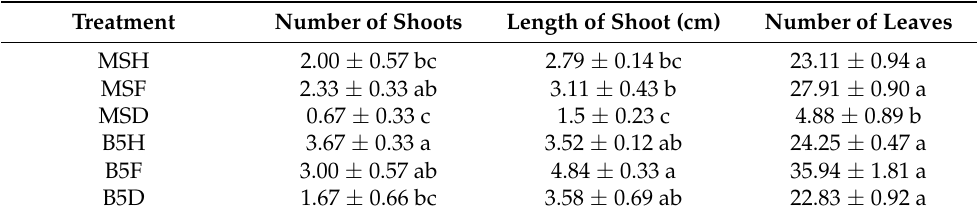
Table 2. Effect of different basal media and its strength towards the number of shoots, length of the shoot (cm), and number of leaves of P. niruri .